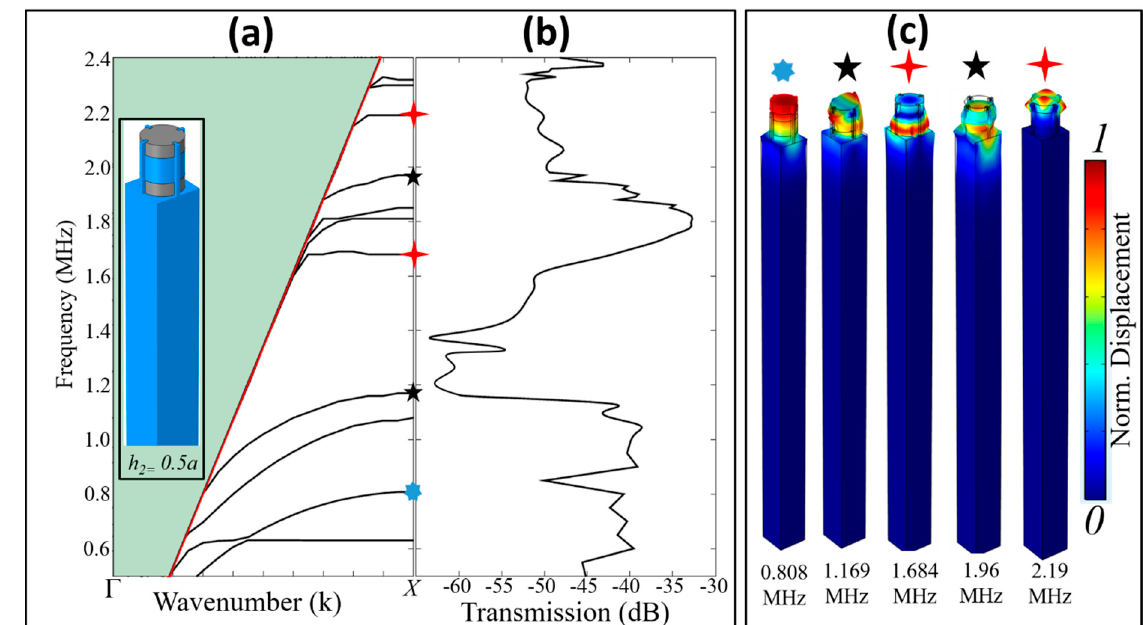
Figure 5. ( a ) SAW band structure; ( b ) transmission curve; and ( c ) SAW PnC vibration modes.